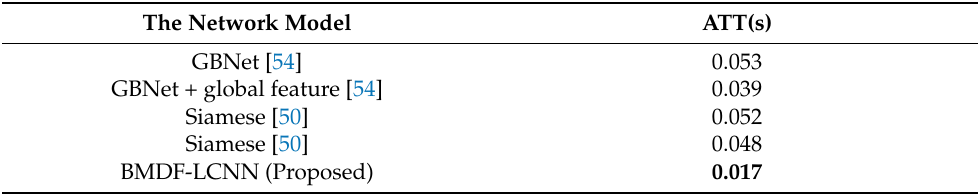
Table 4. The average time between the proposed model and some advanced methods for image